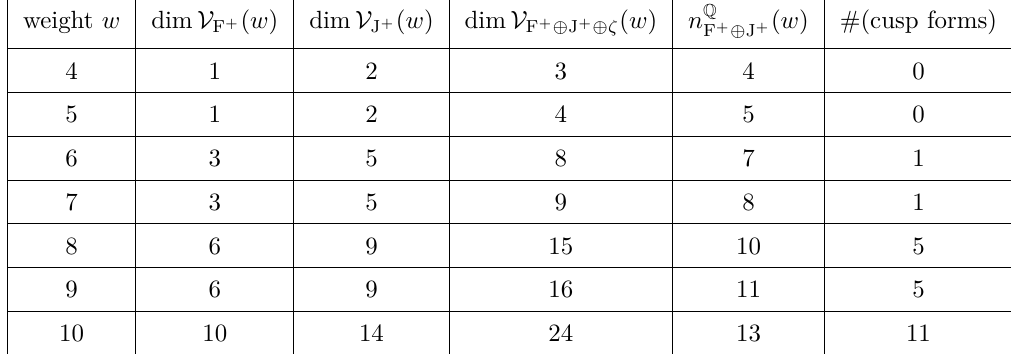
and J +[ ‘ ] . At each odd m,k m,k to the w